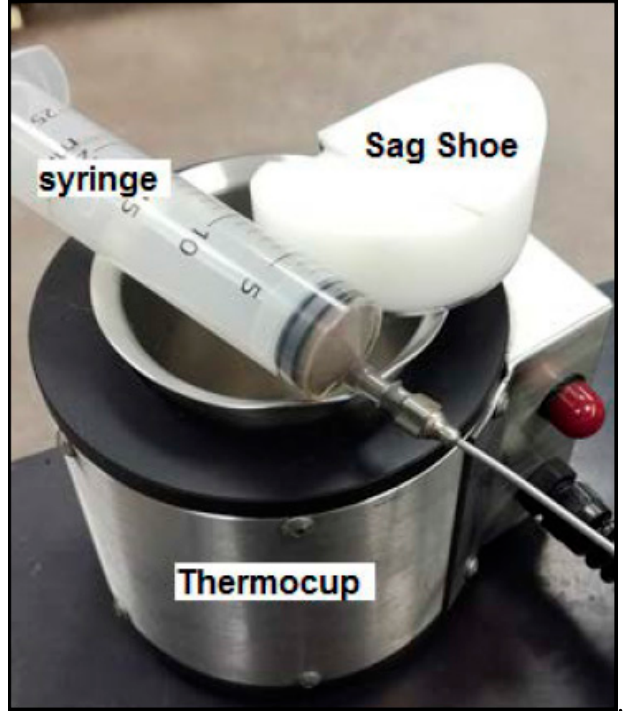
Figure 4. Experimental set-up for viscometer sag shoe test (VSST) excluding the viscometer [ 27 ].